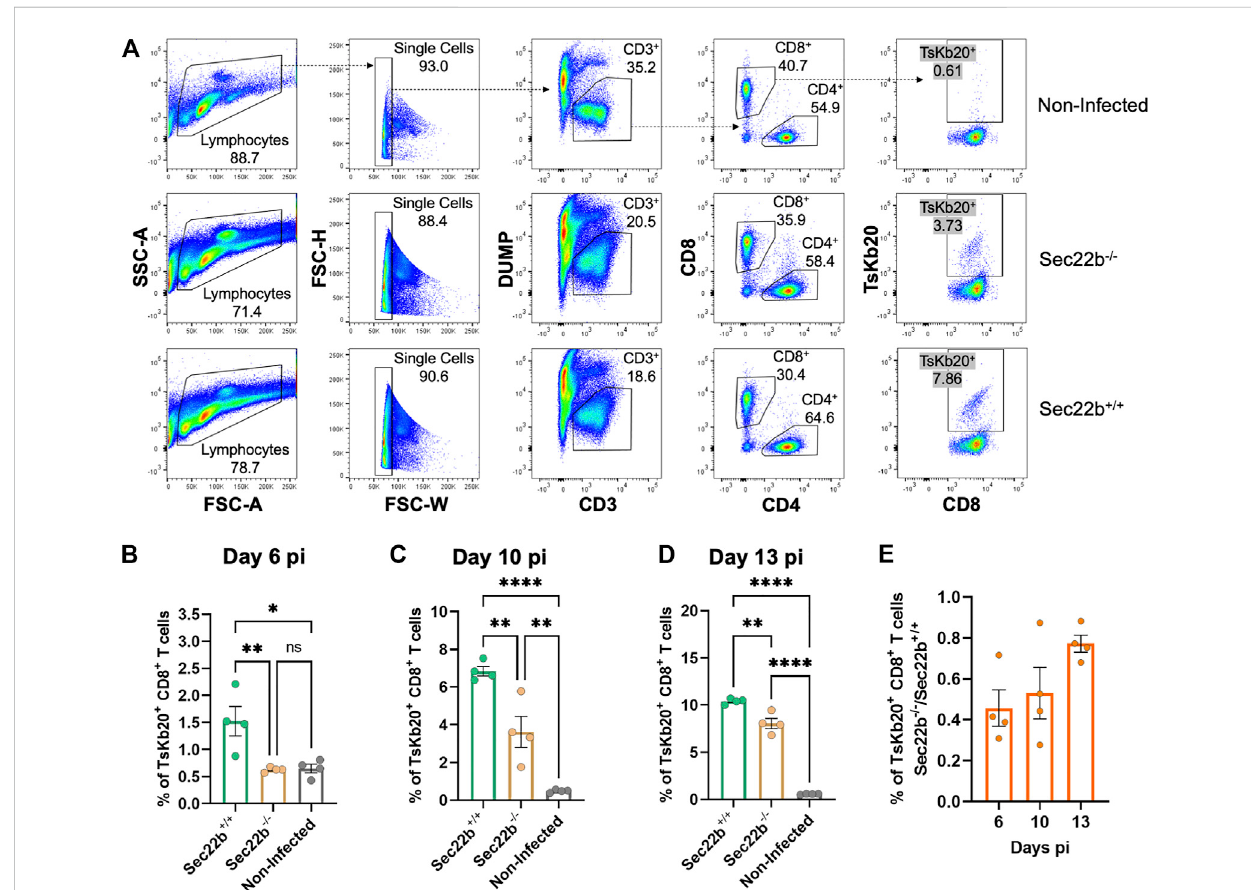
FIGURE 2 Analysis ofthespeci fi cTsKb20-CD8 + Tcells responseinspleen. (A) Gatingstrategy used toanalyze splenocytesatday10 pi.After selectingsinglets, T lymphocytes were determined as CD3 + cells, discriminating from dead cells, B lymphocytes and myeloid cells using a DUMP channel. On the CD3 + population, CD8 + T cells were selected (as positive cells for the CD8 marker) which were then evaluated with the tetramer to measure speci fi c TsKb20- CD8 + T cells. Analysis of the speci fi c TsKb20-CD8 + T cells (%) in spleen at day 6 p. i. (B) ( p-values : Sec22b +/+ vs. Sec22b − / − 0.0100, Non-Infected vs. Sec22b +/+ 0.0115, Non-Infected vs. Sec22b − / − 0.9948); day 10 p. i. (C) ( p-values : Sec22b +/+ vs. Sec22b − / − 0.0035, Non-Infected vs. Sec22b +/+ < 0.0001, Non-Infected vs. Sec22b − / − 0.0042) and day 13 p. i. (D) ( p-values : Sec22b +/+ vs. Sec22b − / − 0.0017, Non-Infected vs. Sec22b +/+ < 0.0001, Non-Infected vs. Sec22b − / − < 0.0001). The analysis was performed using One way ANOVA with Tukey ’ s multiple comparison test, N = 4 (E) Ratio of the percentage